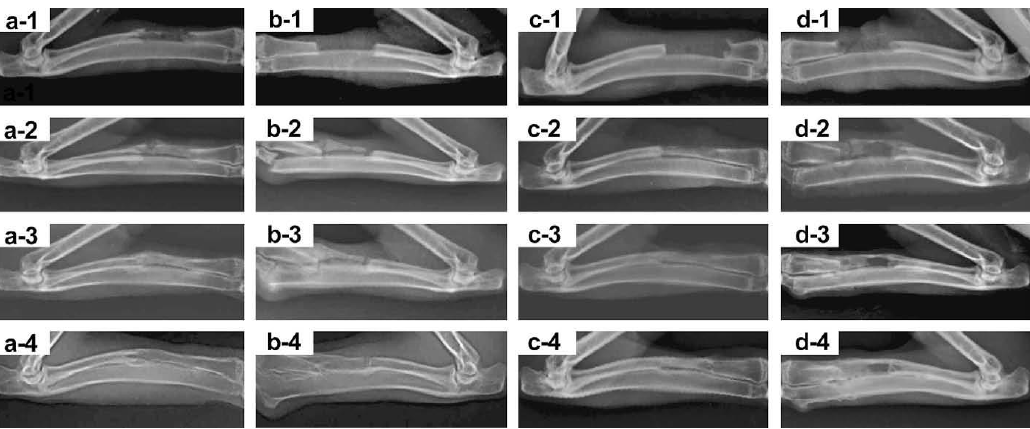
Figure 4. The rabbit radius defects implanted with the porous scaffolds of BMP-2/p-HA/PLGA ( a -1–4), p-HA/PLGA ( b -1–4), HA/PLGA ( c -1–4), and PLGA ( d -1–4) at 0, 2, 4 and 8 weeks post-surgery [147].